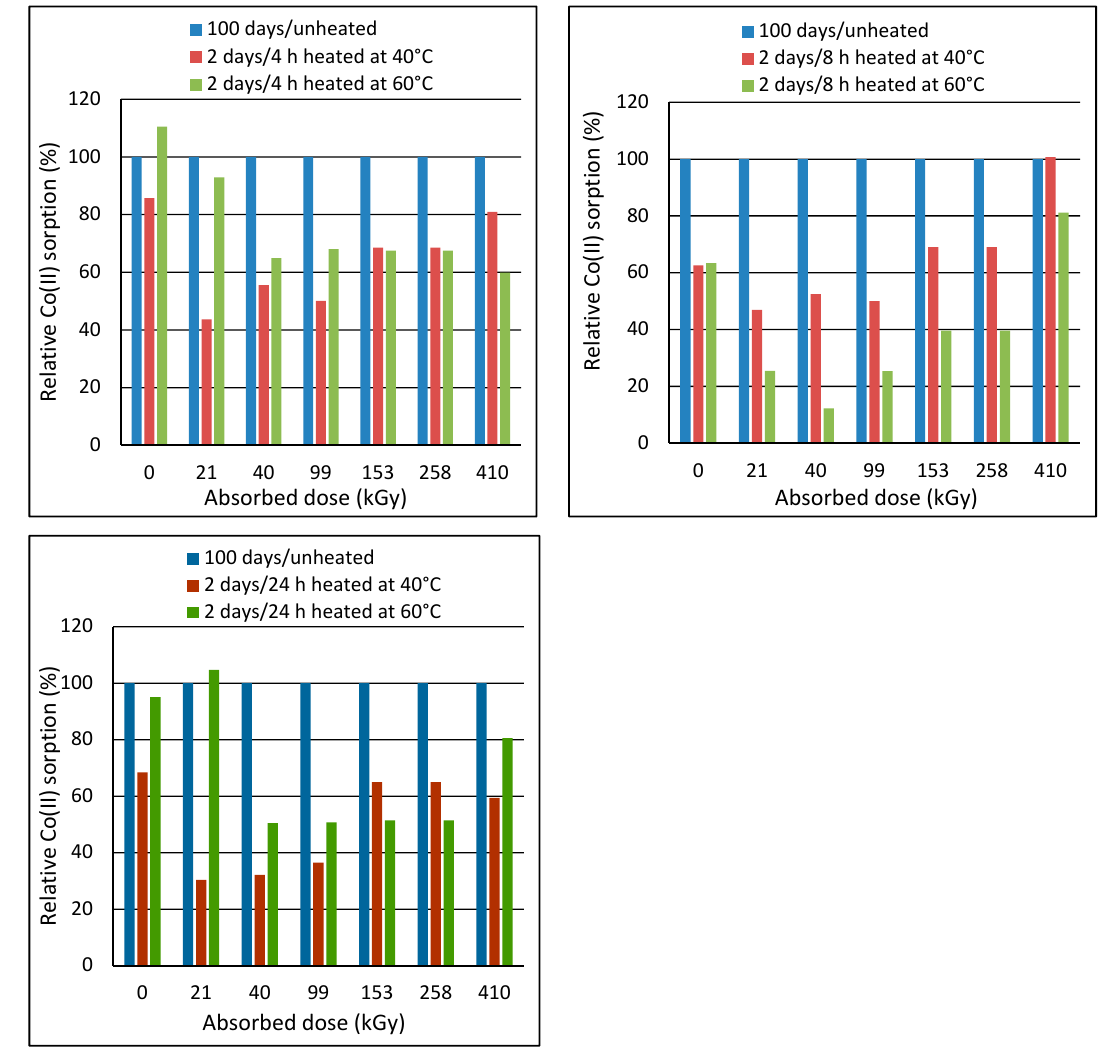
Figure 9. Comparison of Co (II) sorption efficiency on wool with 100-day´s lapse from exposure to wool with 2-day´s lapse and pre-heated at 40 or 60 °C for 4–8–24 h; initial concentration of 150 mmol·dm − 3 .